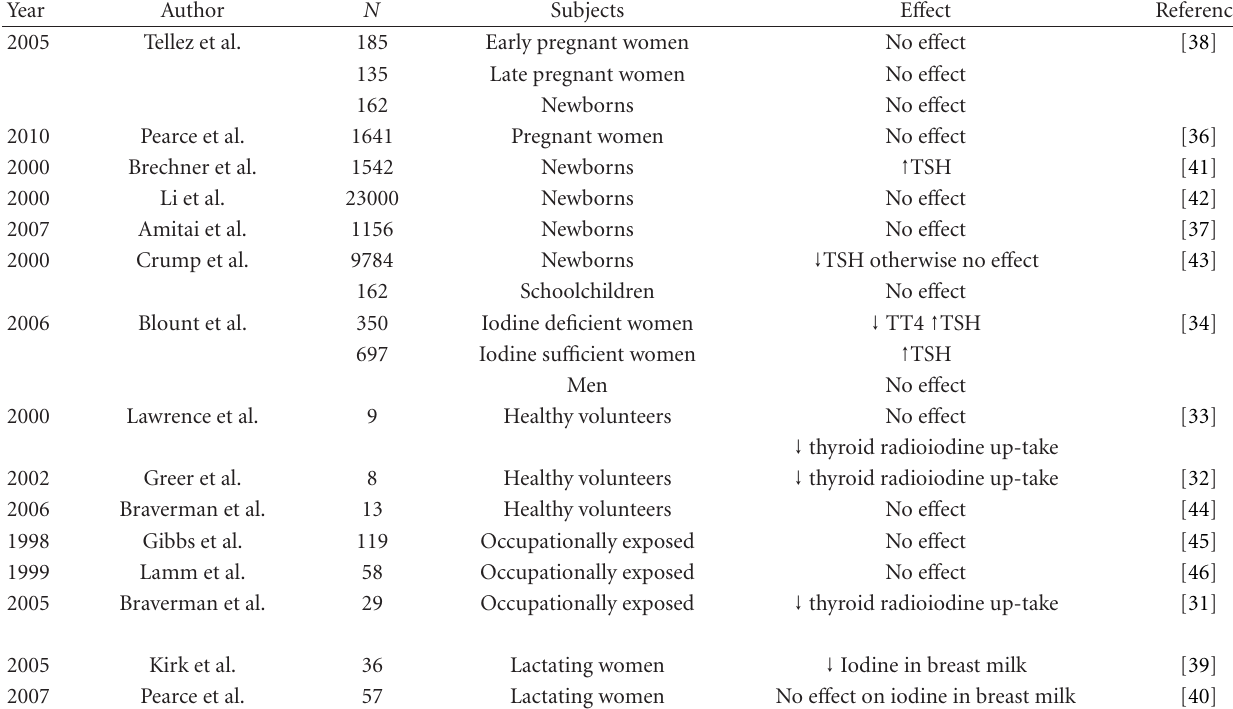
Table 1: Thyroid-disrupting properties of perchlorate in human studies on pregnant women, neonates, infants, adolescents, and adults and the e ff ect of perchlorate on iodine contents in breast